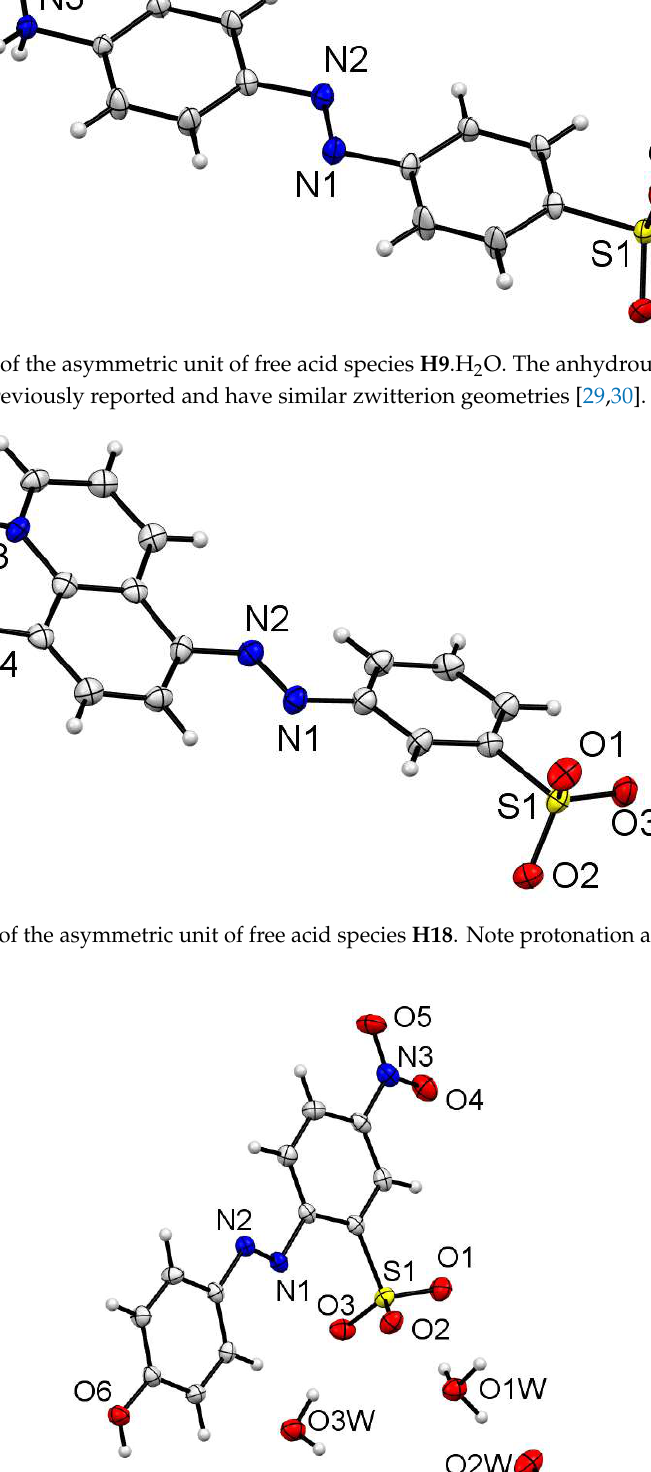
Figure 5. Contents of the asymmetric unit of the hydronium salt form isolated as the “free acid” form of H8 . Although the [H 3 O] + formulation has been used herein, the distance from O3W to the acidic H is 1.43 Å and so a cluster formulation such as [H 5 O 2 ] + is also feasible.